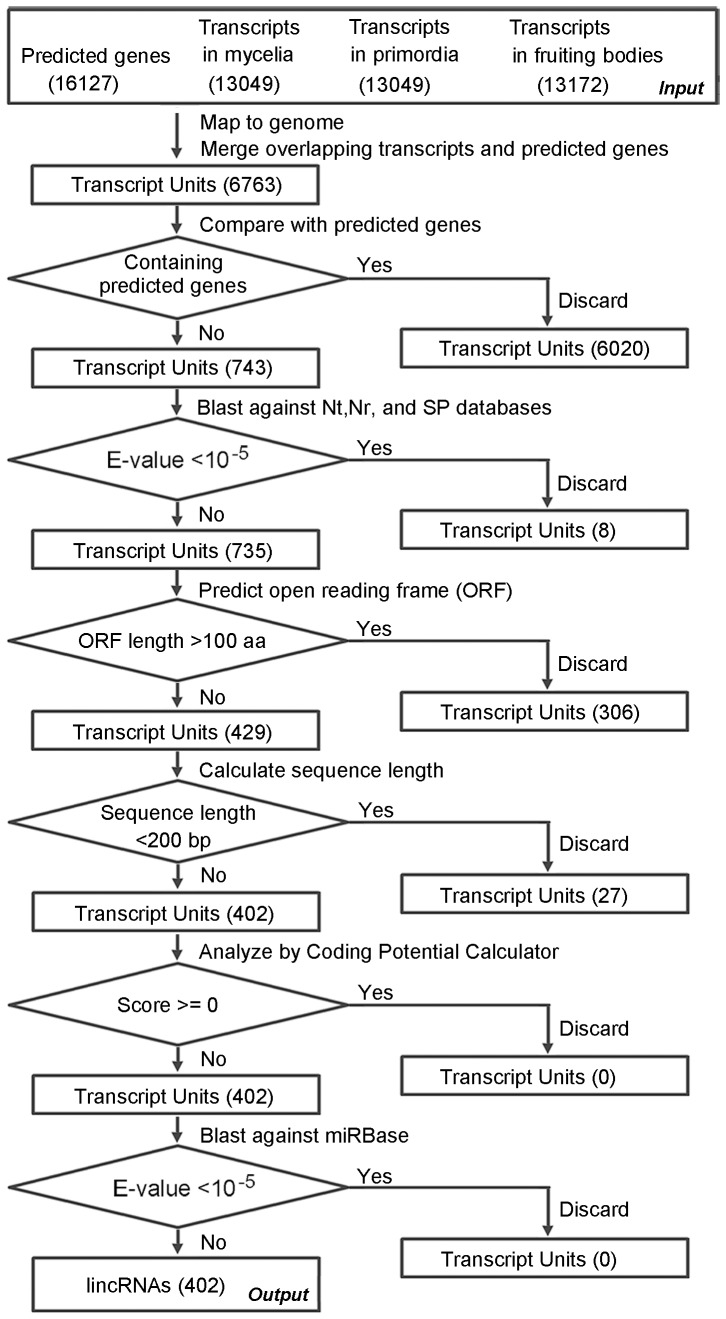
The bioinformatic pipeline used to identify the lincRNA candidates.The predicted genes, transcripts and transcript units (TUs) before and after each filtering step are shown in rectangle. The number of TUs is shown in parenthesis. The filtering process is shown next to the arrowed line above each diamond. The criterion used in each filtering step is shown in diamond.